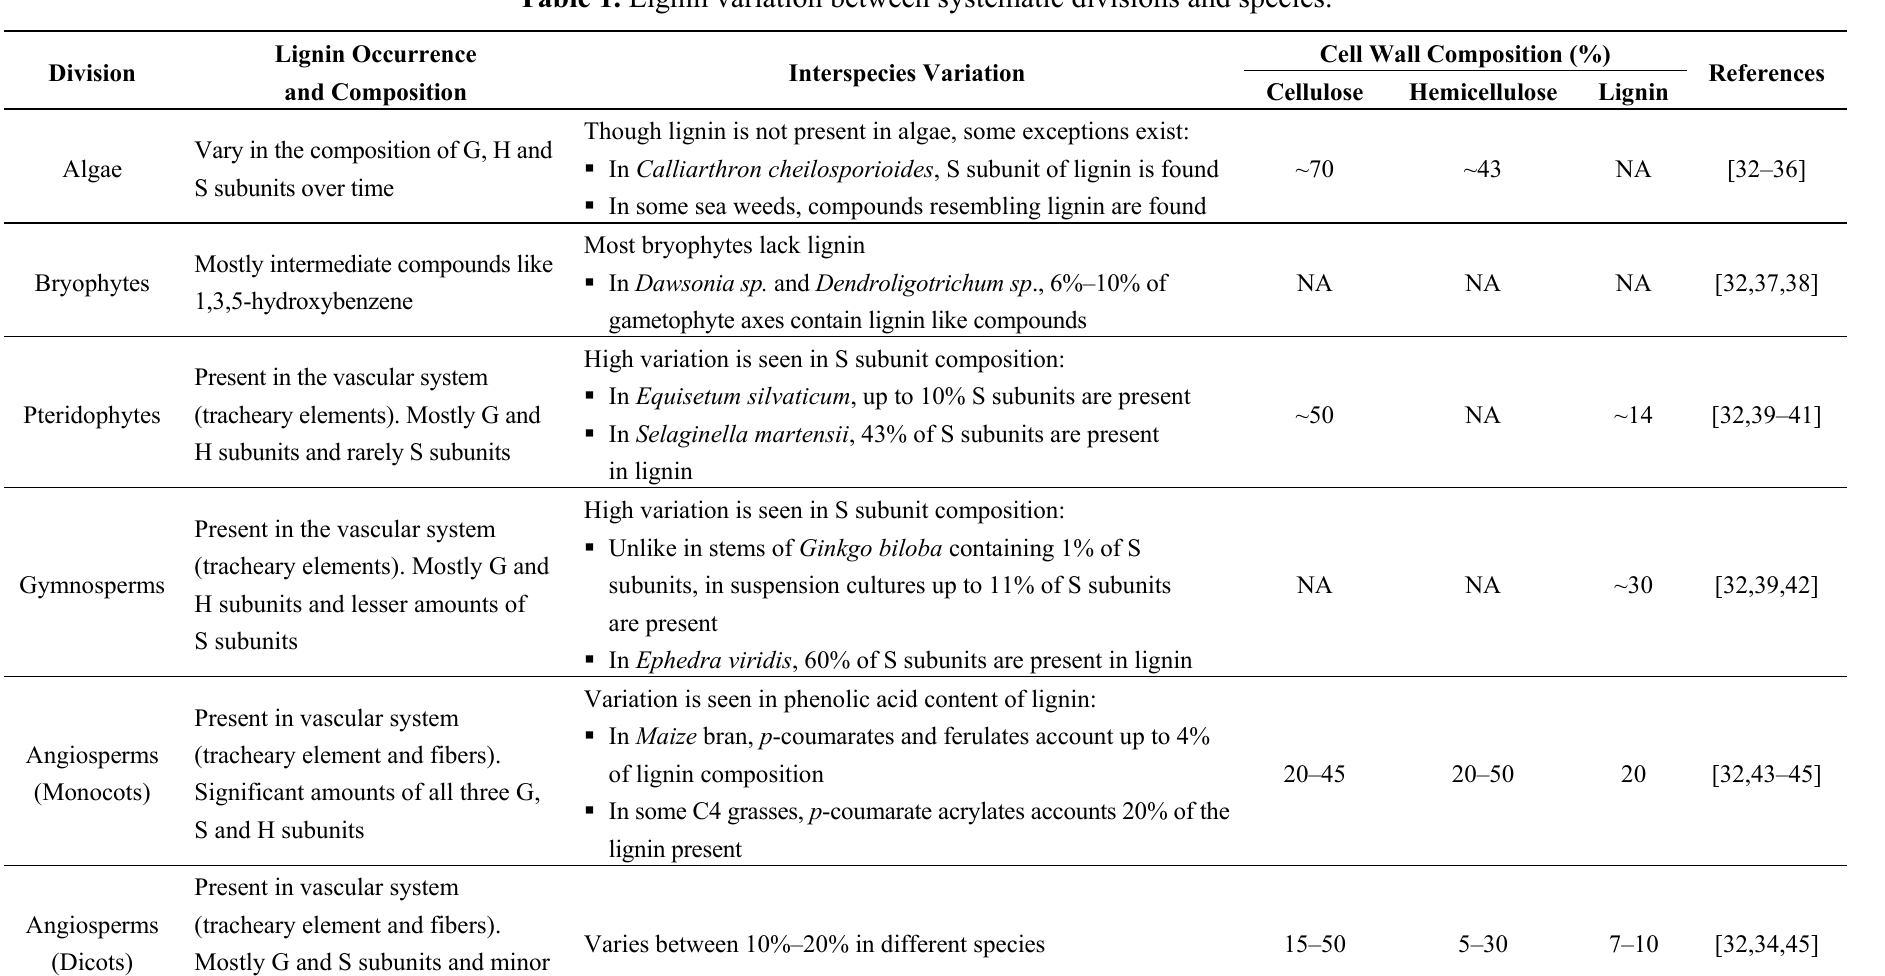
Table 1. Lignin variation between systematic divisions and